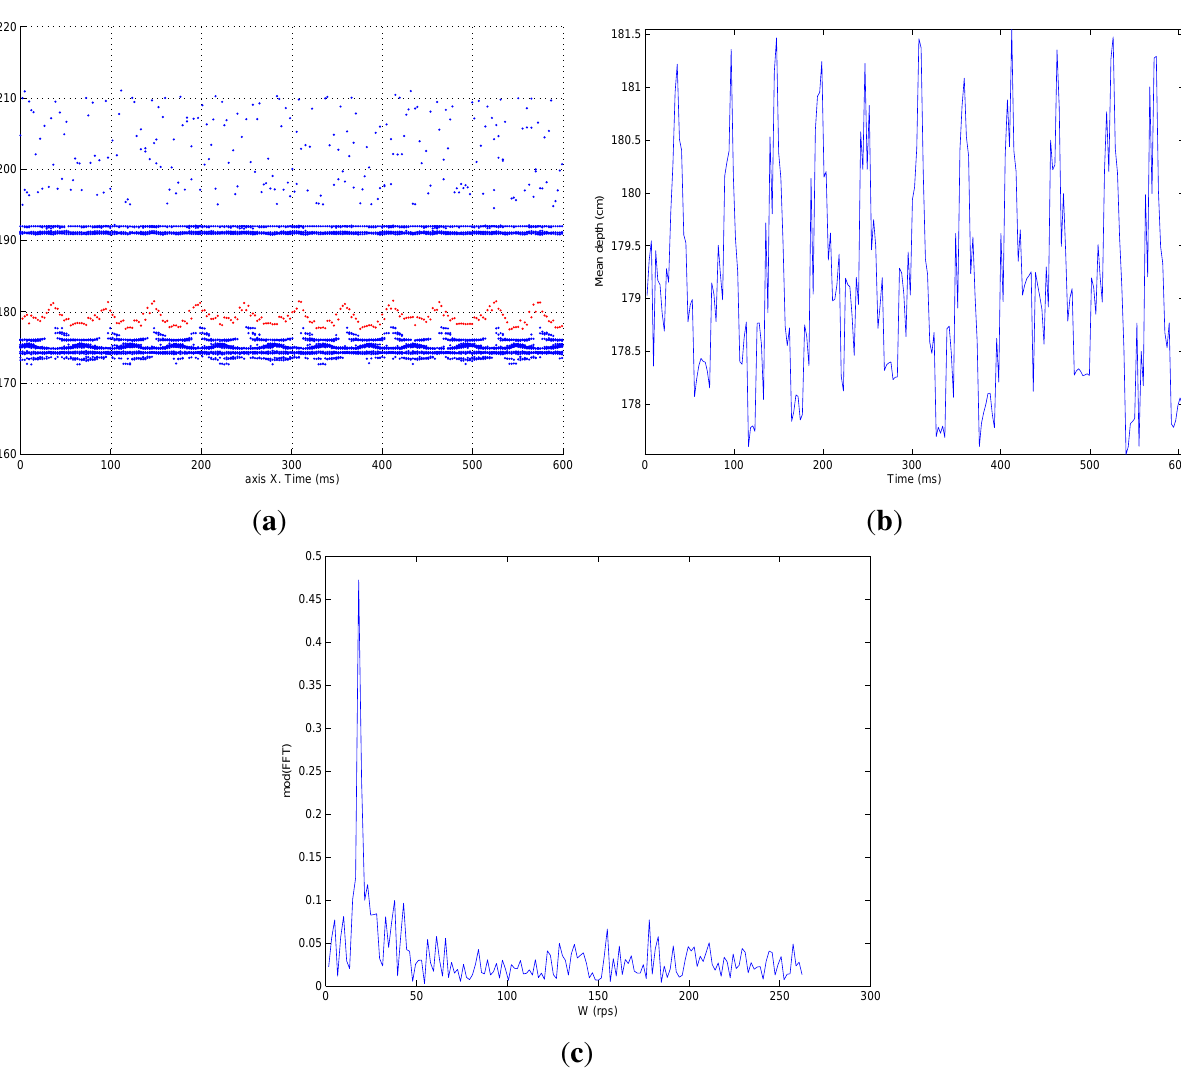
Figure 9. Depth map, average oscillation and FFT for 20 rps helix movement. Classical processing. ( a ) Depth map; ( b ) Average oscillation; ( c )